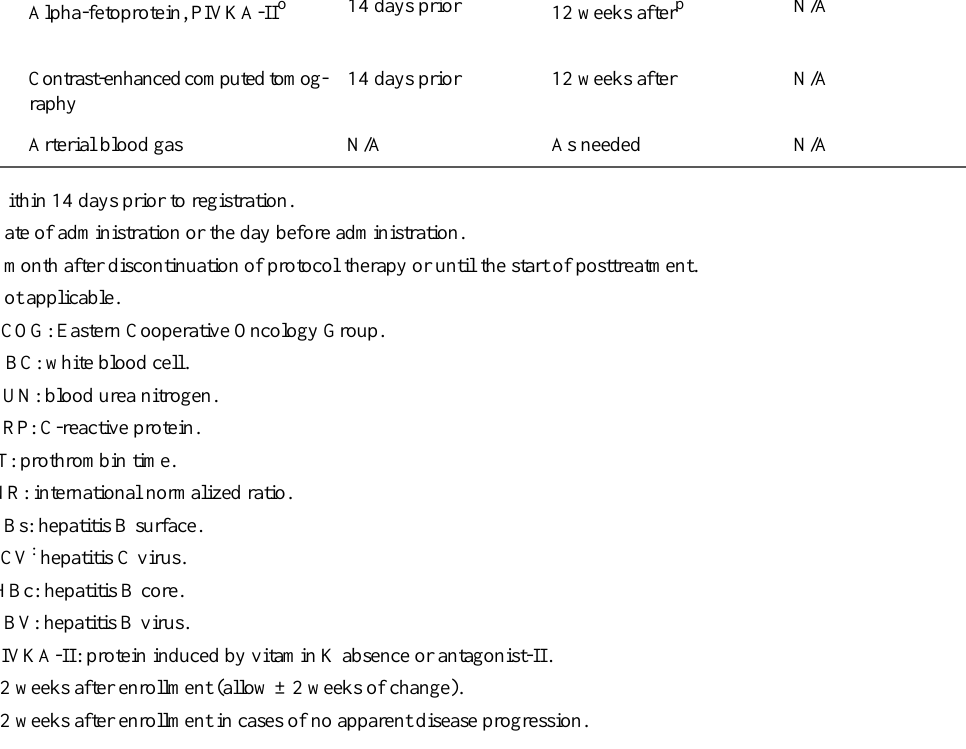
Postprotocol treatmentDuring protocol treatment